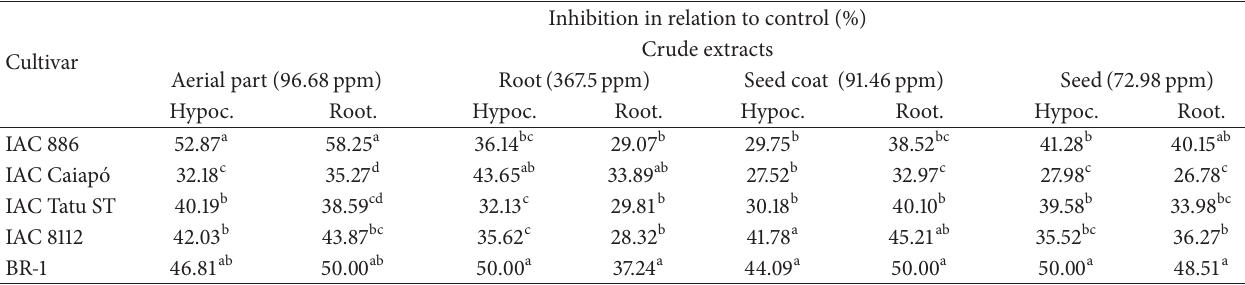
Table 3: Inhibition of L . sativa growth of hypocotyls and rootlets by crude ethanolic extracts of aerial part, root, seed coat, and seed of IAC 886, IAC Caiap´o, IAC Tatu ST, IAC 8112, and BR-1 cultivars from Arachis hypogaea .